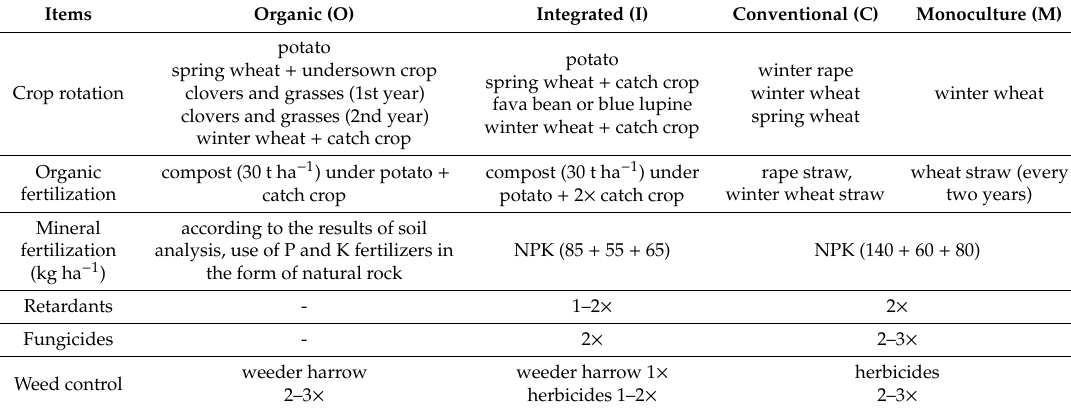
Table 2. Characteristics of di ff erent crop production systems on arable land and major elements of the agricultural practices in winter wheat